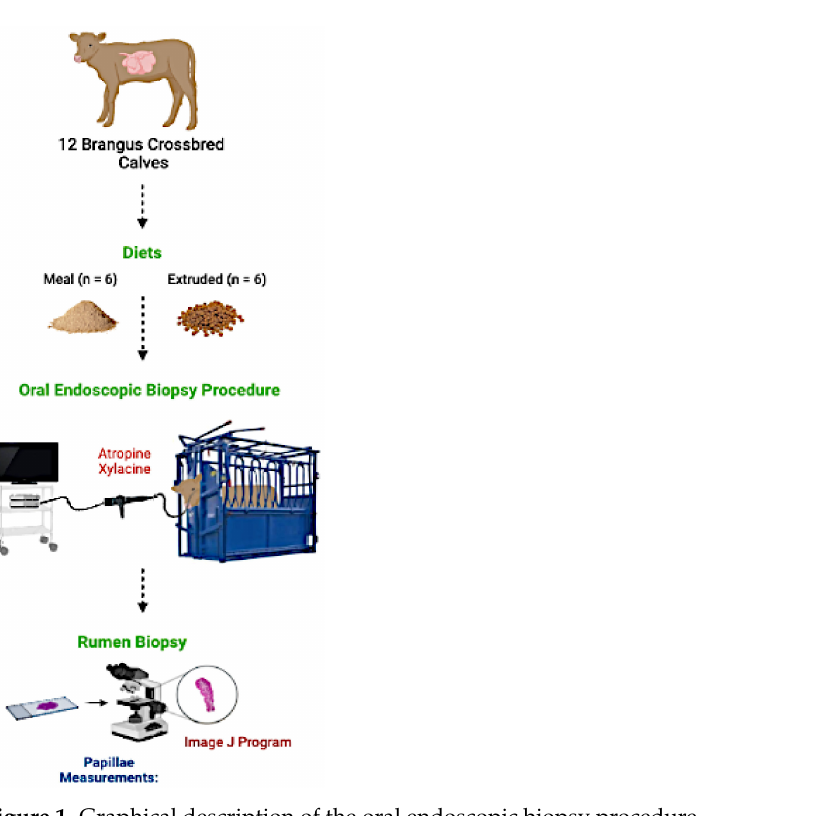
Figure 1. Graphical description of the oral endoscopic biopsy